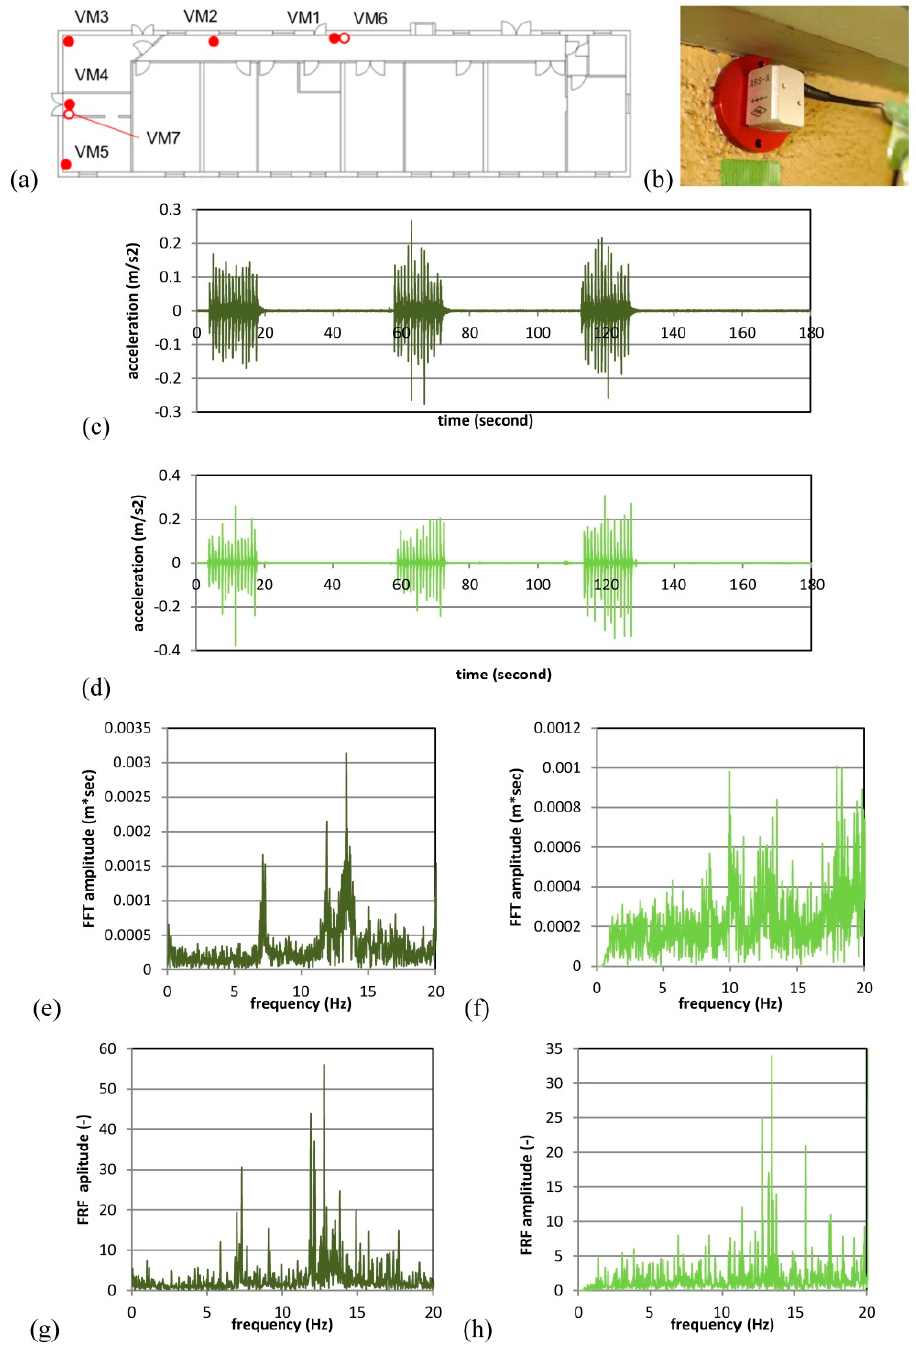
Figure 6. Vibration testing of the Matsumoto storehouse: ( a ) location of the accelerometers, ( b ) installation of an accelerometer, the acceleration time history of forced vibration test of sensor VM1 ( c ) and VM4 ( d ), Fourier spectrum of sensor VM1 ( e ) and of sensor VM4 ( f ), frequency response function of VM1/VM6 sensors ( g ) and of VM4/VM7 sensors ( h ).